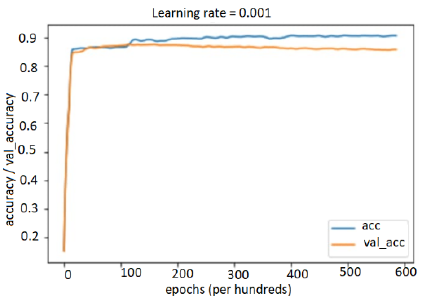
Figure 15. Training accuracy/validation accuracy versus bimodal (text + audio) modality.